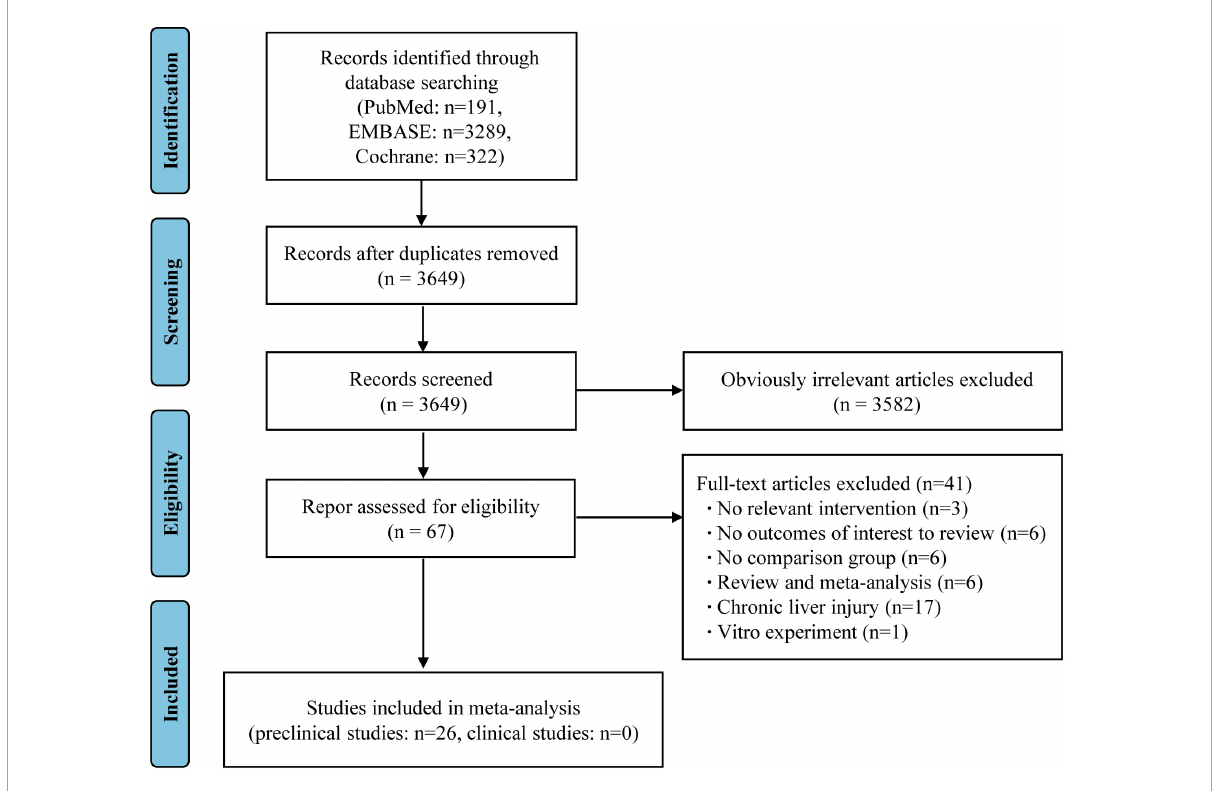
FIGURE1 PRISMA flow diagram for included prospective cohort studies.